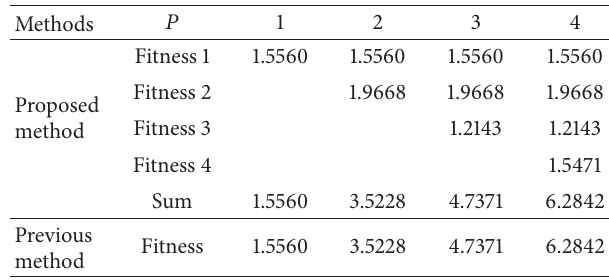
Table 1: The maximum fitness function values got by two methods ( ×10 6